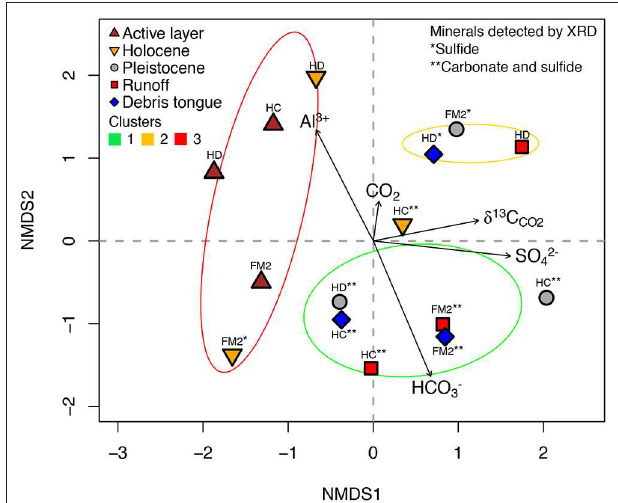
FIGURE 5 | metaMDS results showing similarities between measurements (proximate = more similar) and correlations between measurements and original observations (black text). Note RTS IDs included above measurements. Ellipses constrain statistical clusters in Figure A1 (see section Results in main text).